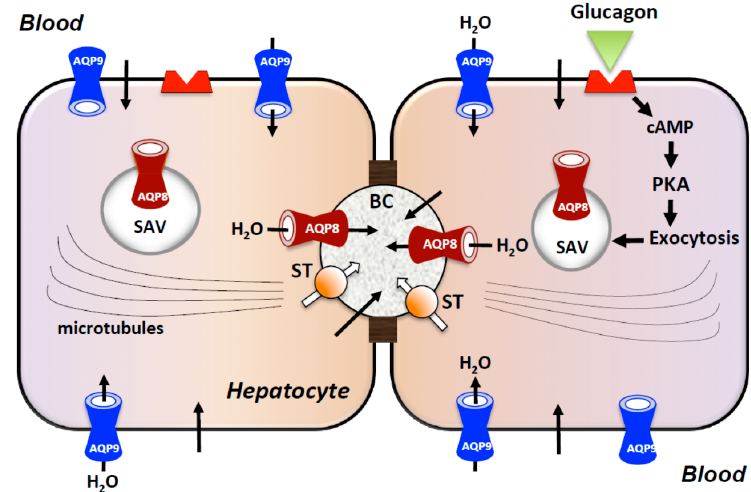
Figure 2. Working model of AQP-facilitated water movement in canalicular bile formation. AQP8 mediates osmotically-driven water secretion into the bile canaliculus (BC), whereas sinusoidal AQP9 contributes to the cellular uptake of water. The choleretic hormone glucagon, after binding to its receptor (in red), stimulates the microtubule-dependent canalicular targeting of AQP8-bearing vesicles located subapically (SAV, subapical vesicles). During the agonist-stimulated hepatocyte bile formation, the transcellular movement of water is coupled osmotically to the active transport of bile salts through pumps and exchangers. PKA, protein kinase A; ST, solute transporters. Black arrows indicate water transport; white arrows indicate solute transport.